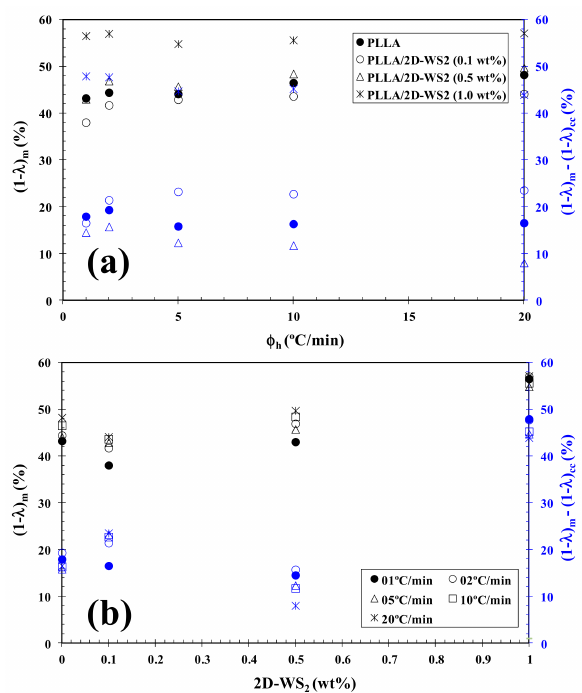
Figure 4. Variation of the cold-crystallization temperature (T cc ) for PLLA/2D-WS 2 nanocomposites with ( a ) heating rate and ( b ) composition.